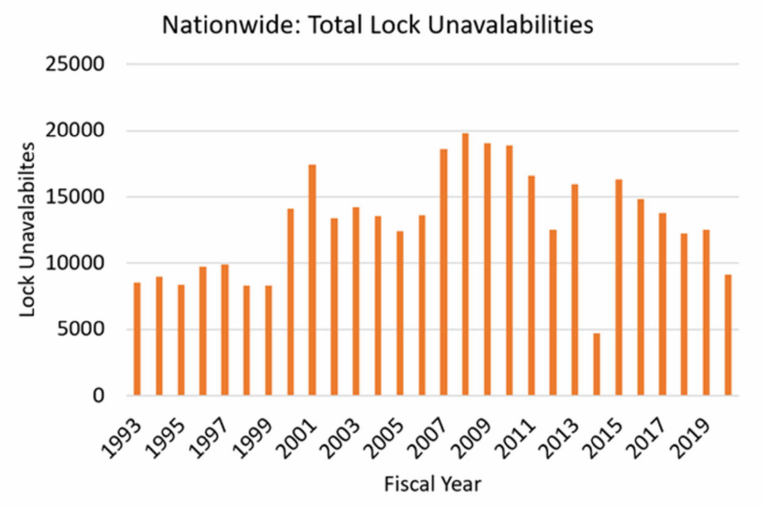
Figure 2. Total nationwide lock unavailability